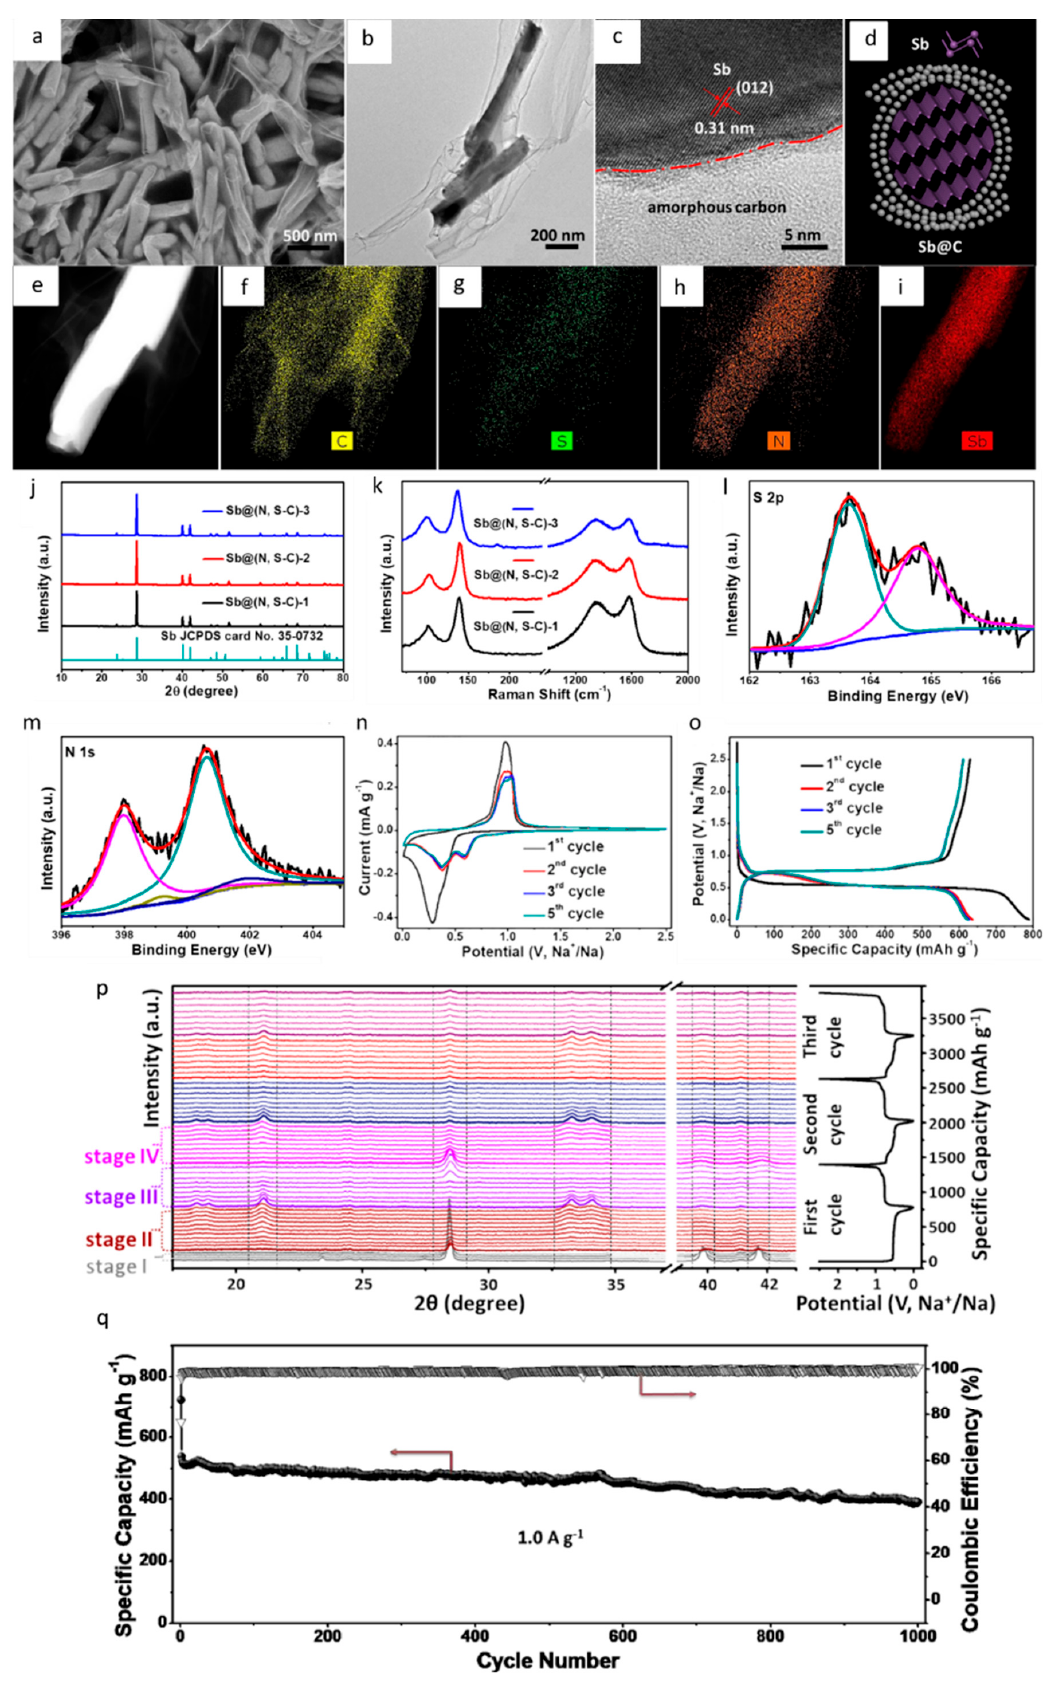
Figure 3. Structural characterization and electrochemical performance analysis of Sb-based alloy (Sb@(N, S − C)) as an anode in SIBs: ( a ) SEM image of Sb@(N, S − C)-2. ( b ) TEM image of Sb@(N, S −